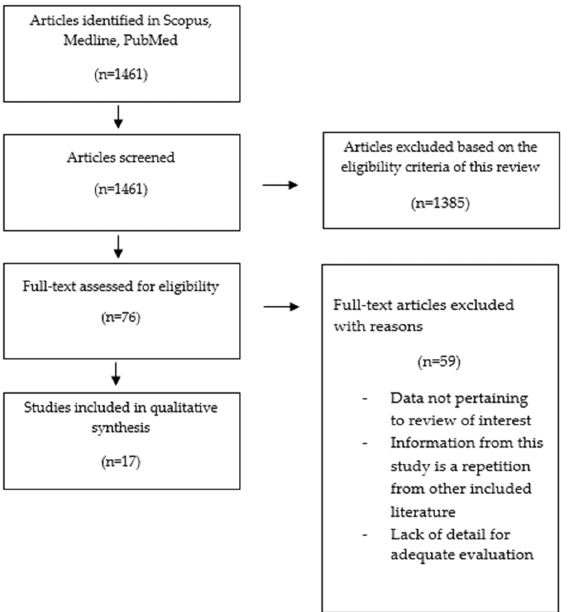
Figure 2. PRISMA flow diagram: schematic diagram of literature search and selection for articles included in this systematic review